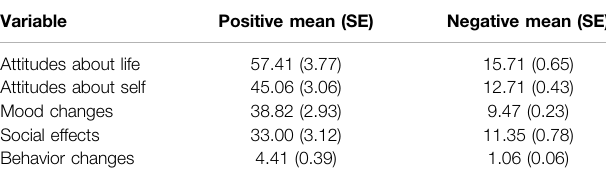
TABLE 3 | Mean (SE) scores on the fi rst part of the Persisting Effects